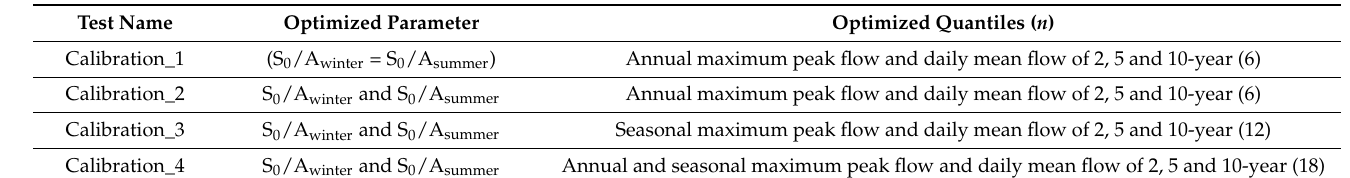
Table 1. Calibration test names and